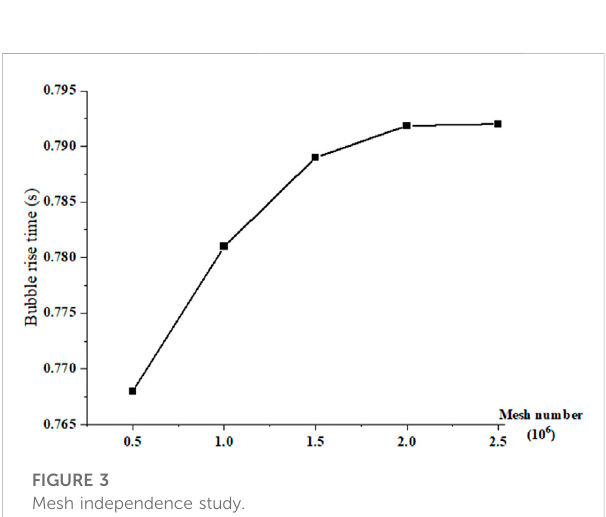
FIGURE 3 Mesh independence